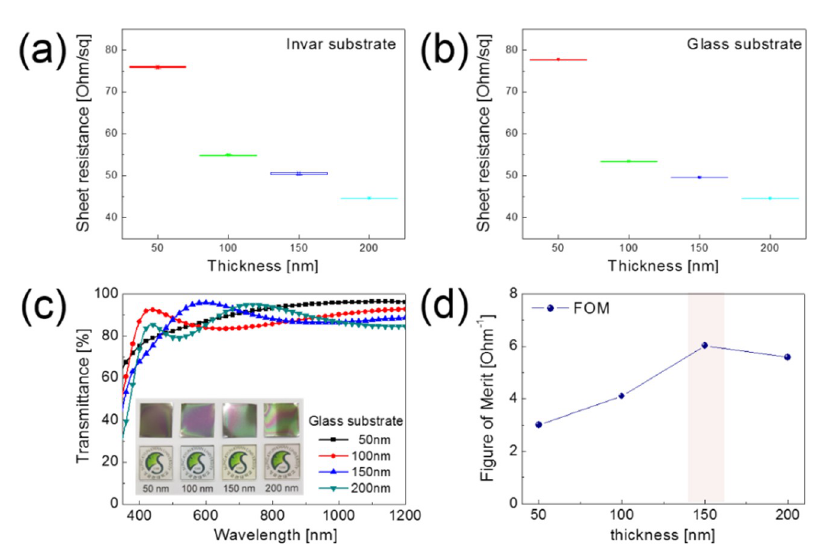
Figure 2. Hall measurement results of ITO films on ( a ) SiO 2 coated invar and ( b ) glass substrates prepared at room temperature with increasing thickness (50, 100, 150, 200 nm). ( c ) Optical transmittance of ITO films on glass substrates. Inset: pictures of ITO films deposited on invar substrates (upper figure) and on glass substrates (lower figure). ( d ) Figure of merit (FoM = T 10 / R sh ) of ITO film on SiO 2 /invar substrates as a function of thickness. Table 1. Sheet resistance of ITO films on the SiO 2 /invar and glass substrates with increasing ITO thickness.